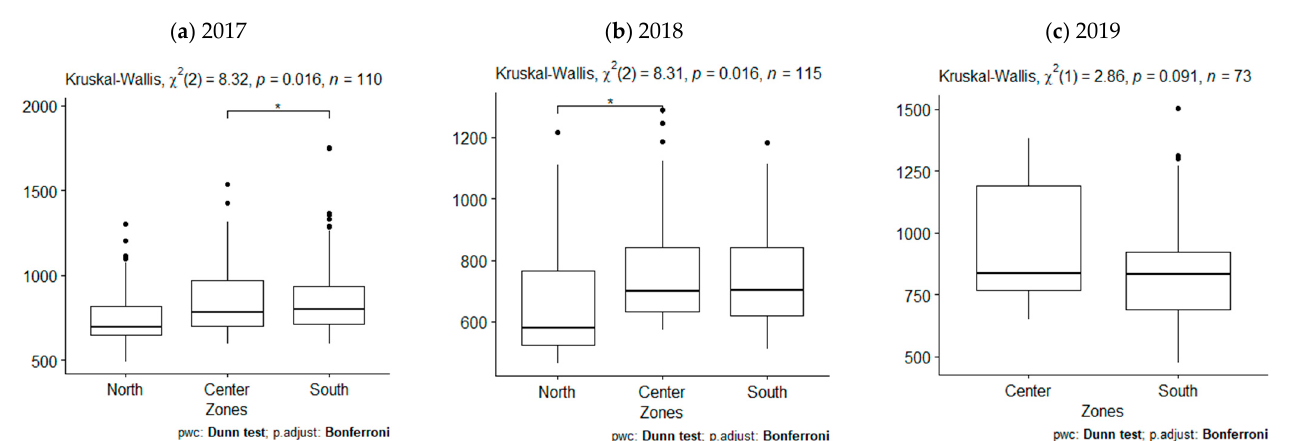
Figure 1. Cowpea grain yields on farmer’s fields from southern to northern Benin during the 2017 ( a ), 2018 ( b ) and 2019 ( c ) rainy seasons. The y-axes (cowpea grain yield) have different scales. * p < 0.05.